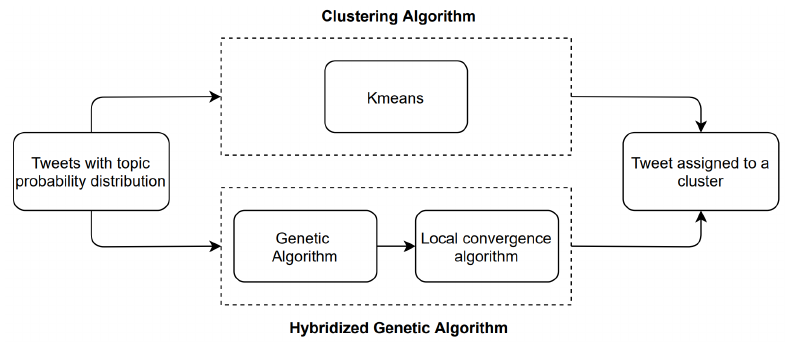
Figure 1. Clustering algorithms